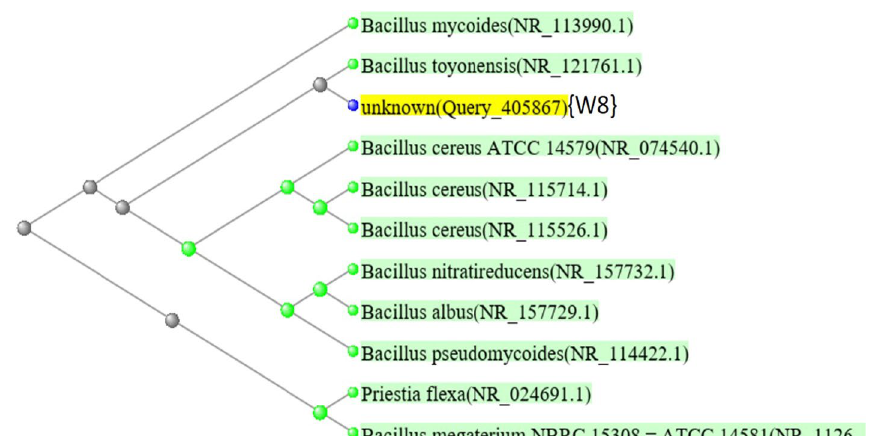
Fig. 3 Phylogenetic tree of the Geobacillus stearothermophilus strain in contrast to the most closely related bacterial strain in the NCBI database ( Geo- bacillus stearothermophilus